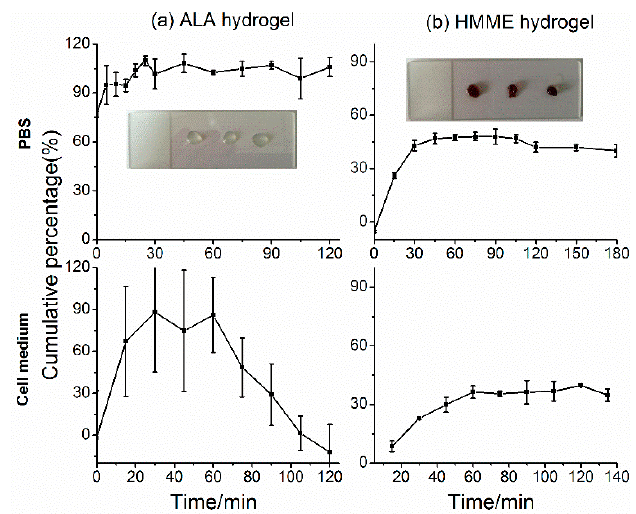
Figure 1. Release studies of photosensitizers (PS) hydrogel in vitro. ( a ) 5-aminolevulinic acid (ALA); ( b ) Hematoporphyrin monomethyl ether (HMME). The upper row refers to the release of PS hydrogel in PBS, and the lower row indicates the release of PS hydrogel in RPMI1640 medium with SW837 cells cultured. The inserts show the appearance of the formed PS hydrogel.